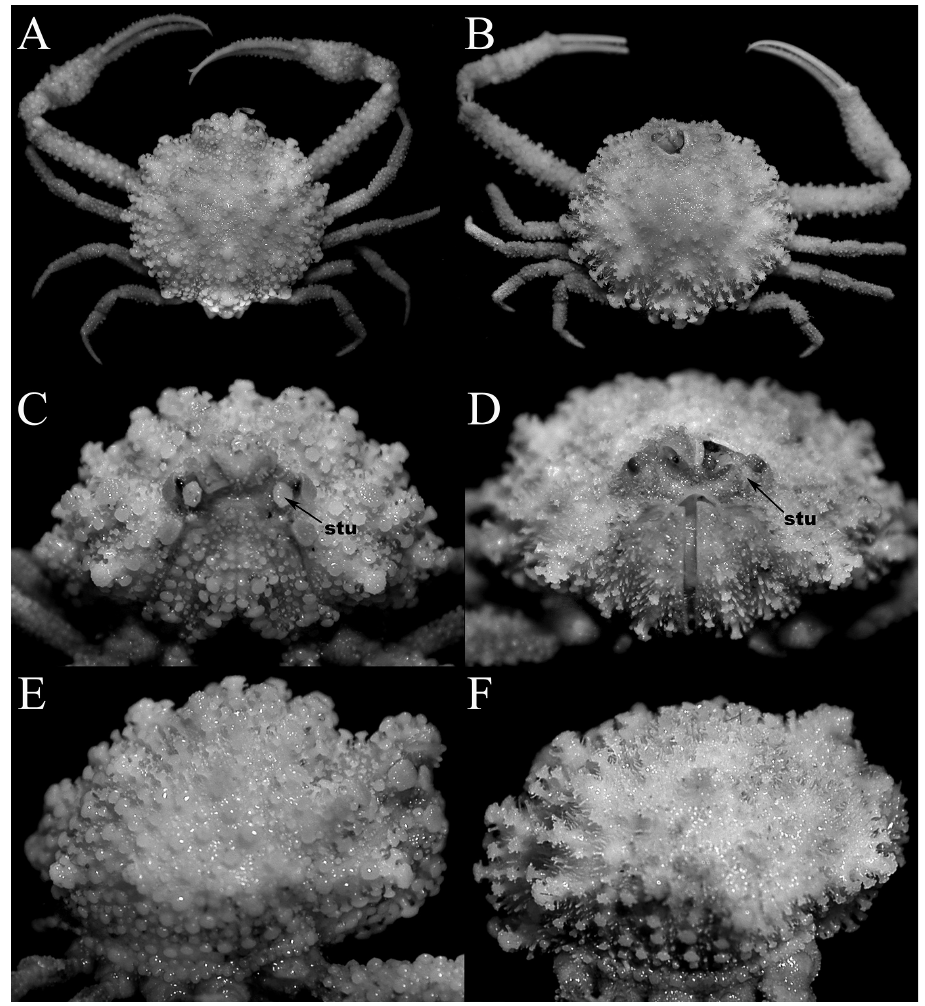
Figure 11. Comparisons between similar sized Pariphiculus agariciferus Ihle, 1918, and P. stellatus sp. n. A, C, E P. agariciferus , male (15.8 × 15.8 mm) (ZRC 2007.588), Philippines B, D, F P. stellatus , male (15.4 × 13.8 mm) (ZRC 2017.184), Philippines [left frontal margin damaged]. A, B overall dorsal view C, D frontal view of cephalothorax showing orbit, antennae, antennules and buccal cavity E, F right lateral view of cephalothorax. Abbreviation: stu = suborbital